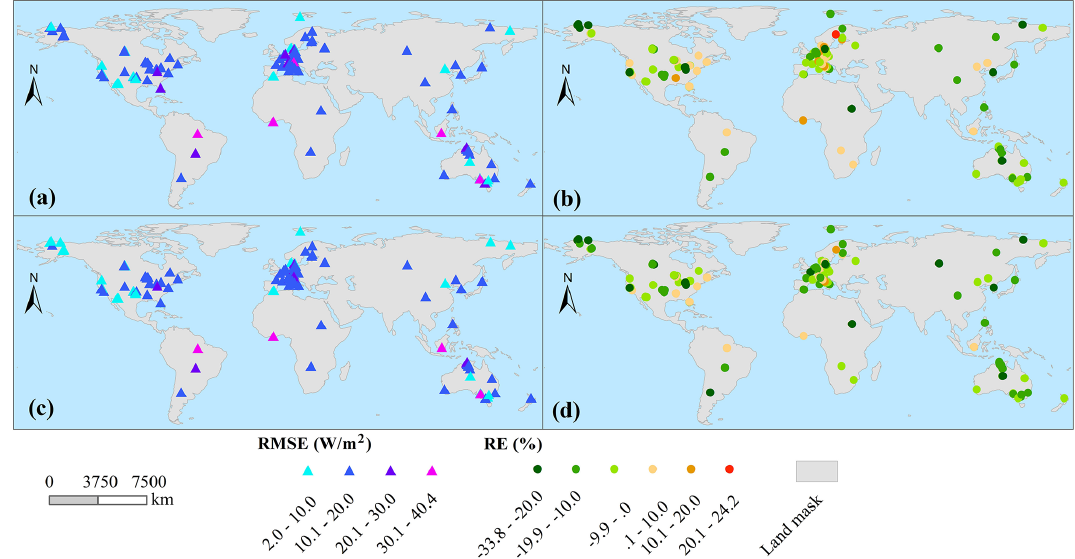
Figure 6. Spatial distribution of RE and RMSE simulated by the sine function and EF( R e ) methods using multi-time values ( a and b are simulated by the sine function method, and c and d are simulated by the EF( R e ) method; a and c are RMSE, and b and d are RE).